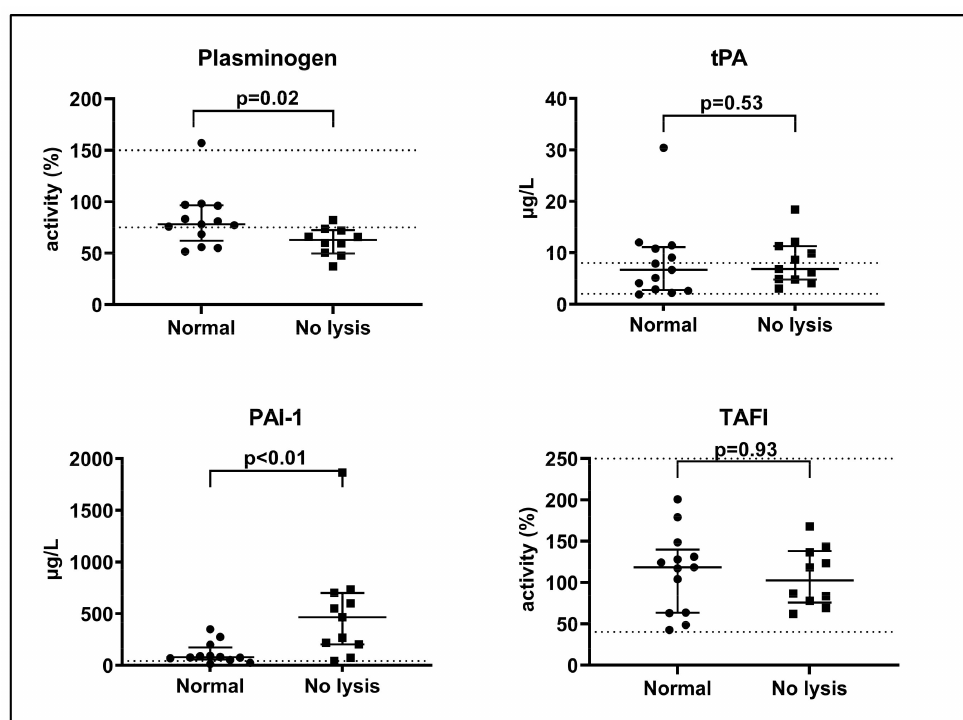
Figure 2. Plasminogen, tissue plasminogen activator (tPA), plasminogen activator inhibitor (PAI)- 1 and thrombin-activatable fibrinolysis inhibitor (TAFI) in patients with normal lysis and lysis resistance on day 1. Median with interquartile range is shown. p -values indicate comparison between normal and lysis-resistant curves ( t -test or Mann–Whitney’s test). Dotted lines indicate upper/lower reference limits as provided by the manufacturers.